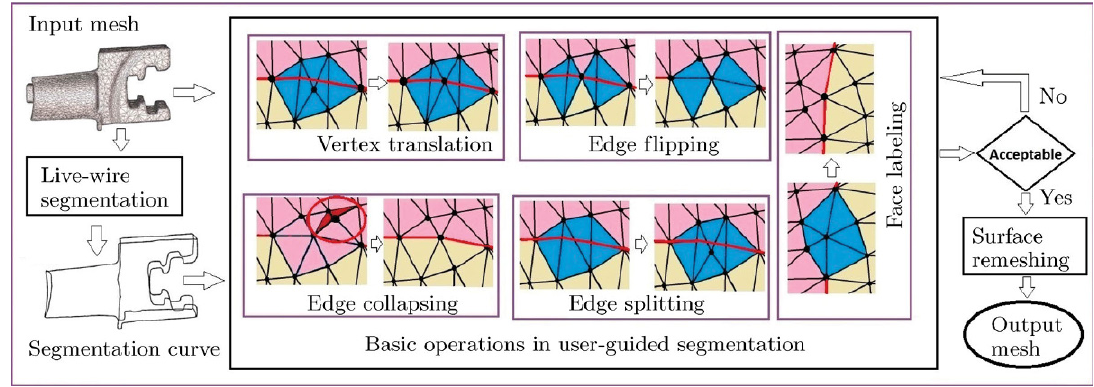
Fig. 1 Proposed user-guided segmentation with remeshing. In the basic operations (middle), red lines represent segmentation curves and the blue color shows unlabeled faces near the